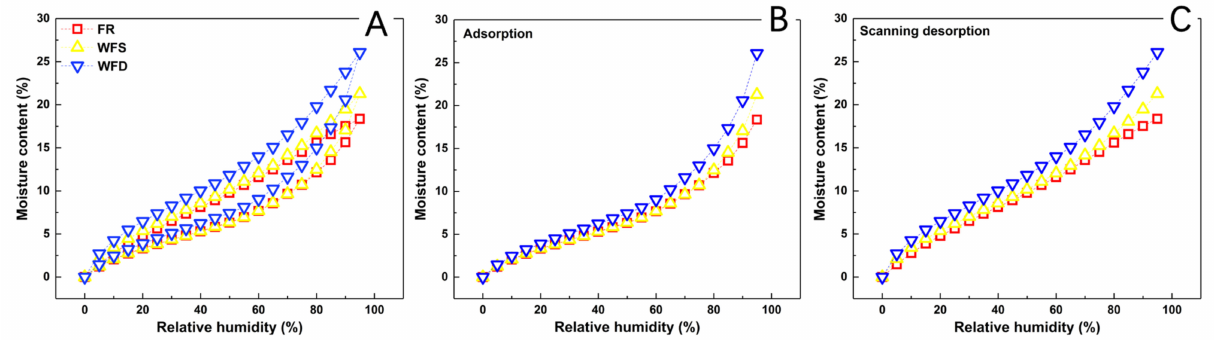
Figure 2. Sorption isotherms of waterlogged archaeological wood and recent wood. ( A ) Adsorption and desorption isotherm, ( B ) adsorption isotherm, and ( C ) scanning desorption isotherm. FR: recent fir wood, WFS: waterlogged archaeological fir wood from a sound region, WFD: waterlogged archaeological fir wood from a decay